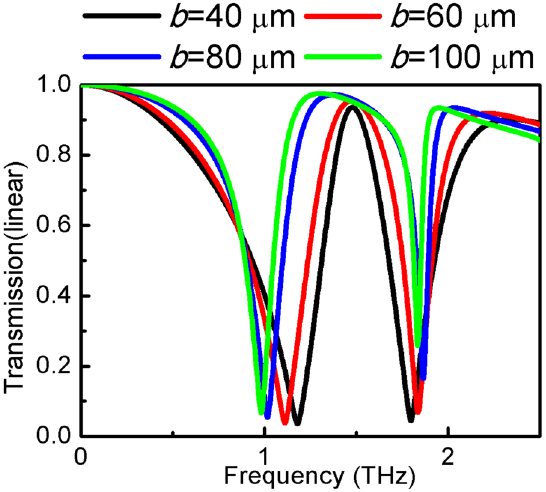
Figure 8. Transmission spectra of different b at s 1 = s 2 = 20 μ m. a = 100 μ m, d = 0.02 μ m, d 2 = 12 μ m, l 1 = 80 μ m, h = 26 μ m, w = 4 μ m, l